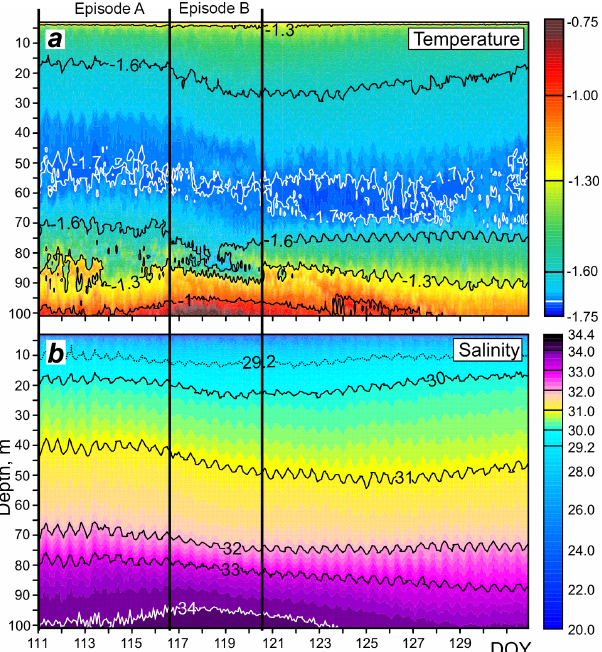
Figure 2. The temporal evolution of (a) temperature and (b) salinity measured by the ITP between 21 April, 00:00UTC, and 11 May, 21:00UTC, at the FIIC glacier terminus. The horizontal axis shows day of year